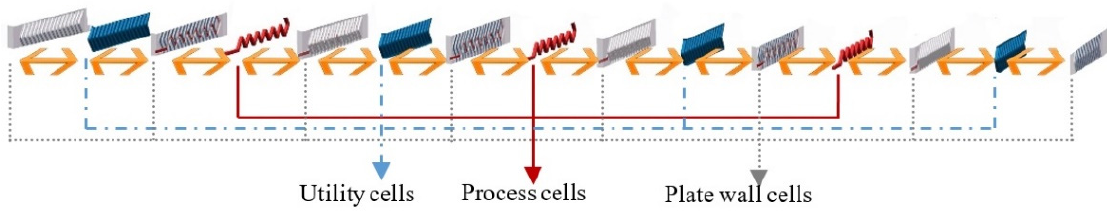
Figure 4. Internal description of one computing unit and convective heat exchange.